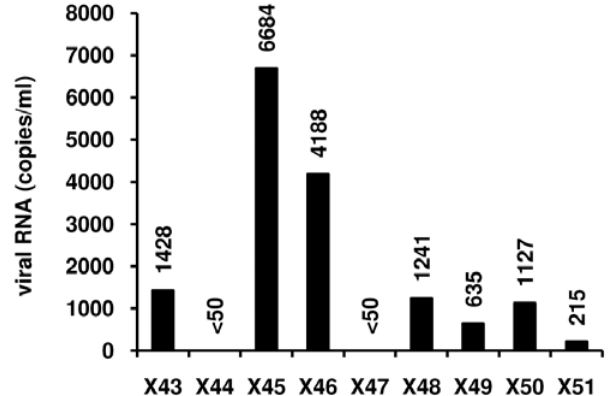
Figure 9. Effects of prostratin + SAHA treatment on HIV-1 recovery in HLA DR 2 CD4 + T cells. HLA DR 2 CD4 + T cells from HAART-treated patients with undetectable viral load (X43 to X51) were mock-treated or treated with the combination prostratin (5 m M) + SAHA (2.5 m M). Six days after treatment, HIV-1 genomic RNA concentrations were measured in culture supernatants as described in Materials and Methods.